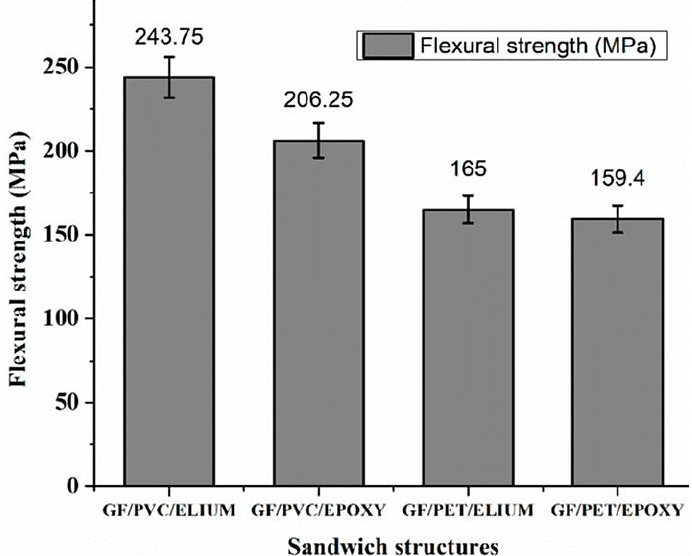
Figure 8. Flexural strength of the sandwich composite structures [75]. GF/PVC/Elium = glass fiber/poly(vinyl chloride)/Elium resin; GF/PET/Elium = glass fiber/polyethylene terephthalate/Elium resin; GF/PVC/epoxy = glass fiber/poly(vinyl chloride)/epoxy resin; GF/PET/Elium = glass fiber/polyethylene terephthalate/epoxy resin. Reproduced with permission from MDPI.